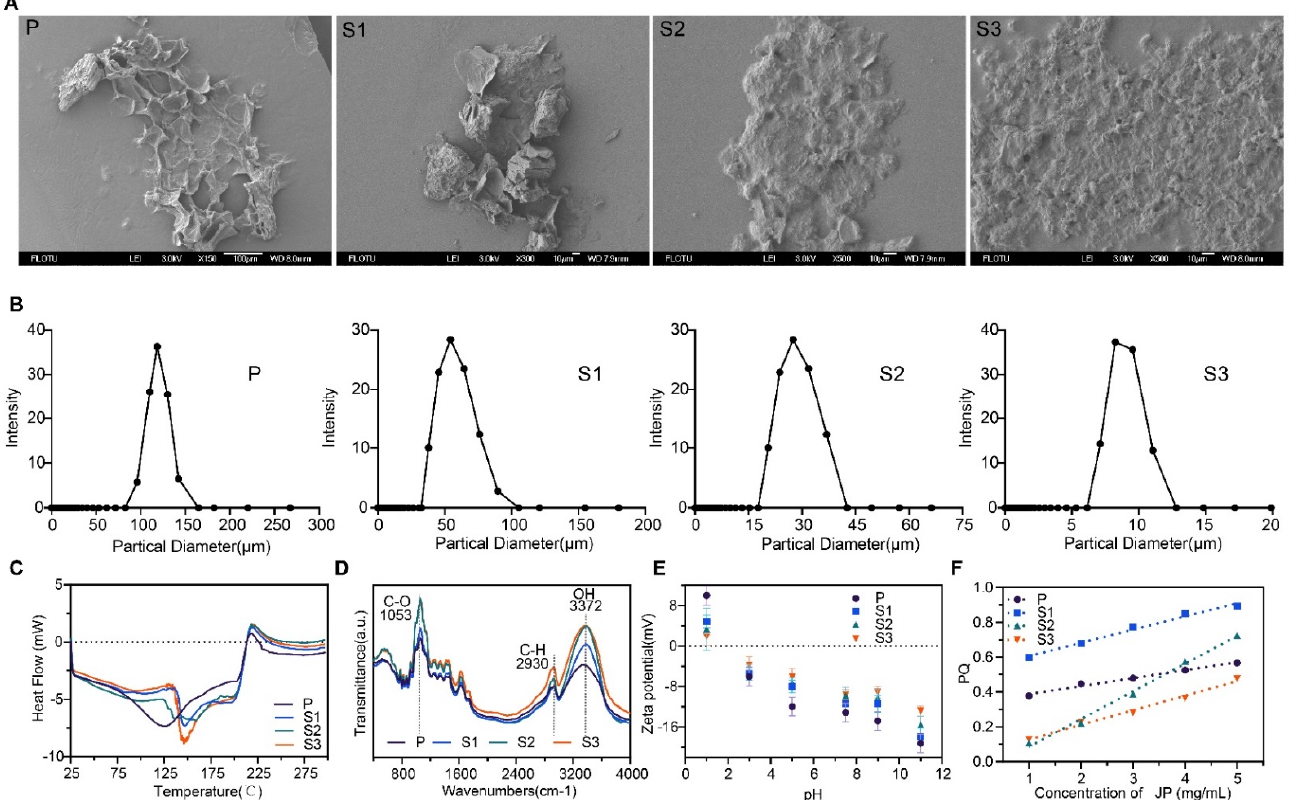
Figure 1. Morphological and surface properties of jujube powder characterized by ( A ) SEM micrographs, ( B ) particle size distributions, ( C ) DSC, ( D ) FTIR spectra, ( E ) zeta potential, and ( F ) hydrophobicity.